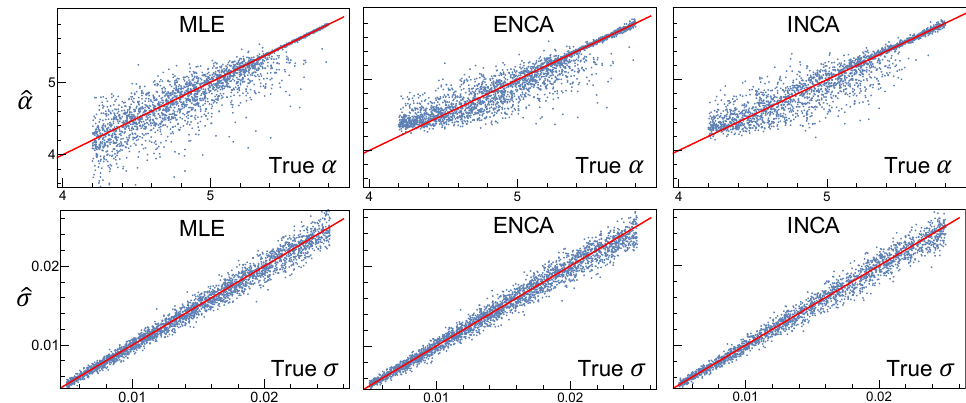
Figure 3: MLEs (using eqs. (10 and (11)) for the parameters of model (9) (left panels), parameter regression from the ENCA- (middle panels), and the INCA-encoder (right panels). Both ENCA and INCA are trained with q = 3 summary statistics. The upper row of plots shows a clear accuracy-difference for the two attractors of the model.